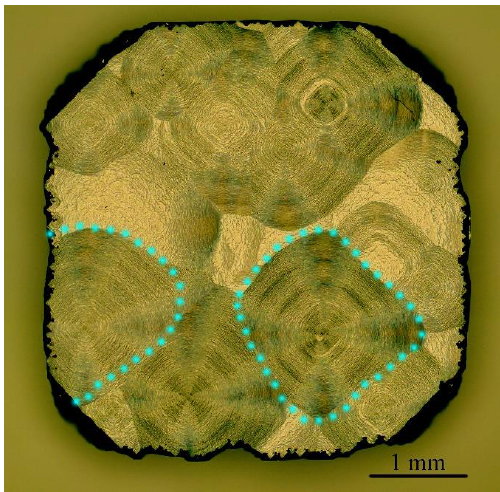
Figure 4. Optical microscope image of the surface morphology of sample 1 prepared with intentional addition of N 2 . The blue dotted lines mark the conical and pyramidal features on the surface.